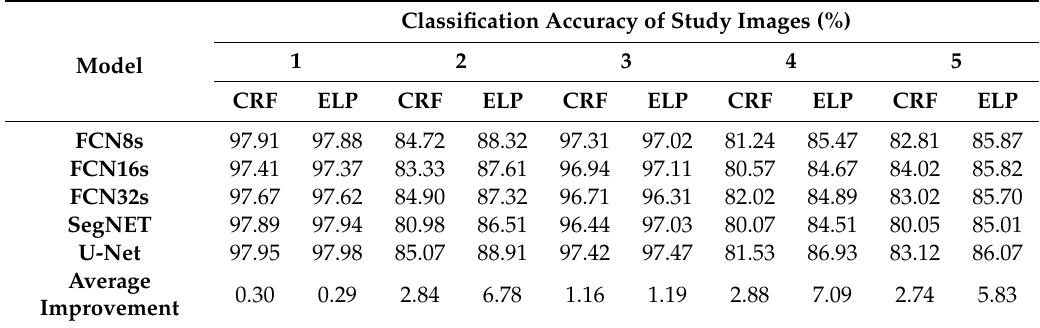
Table 4. Correction accuracy comparisons of CRF and